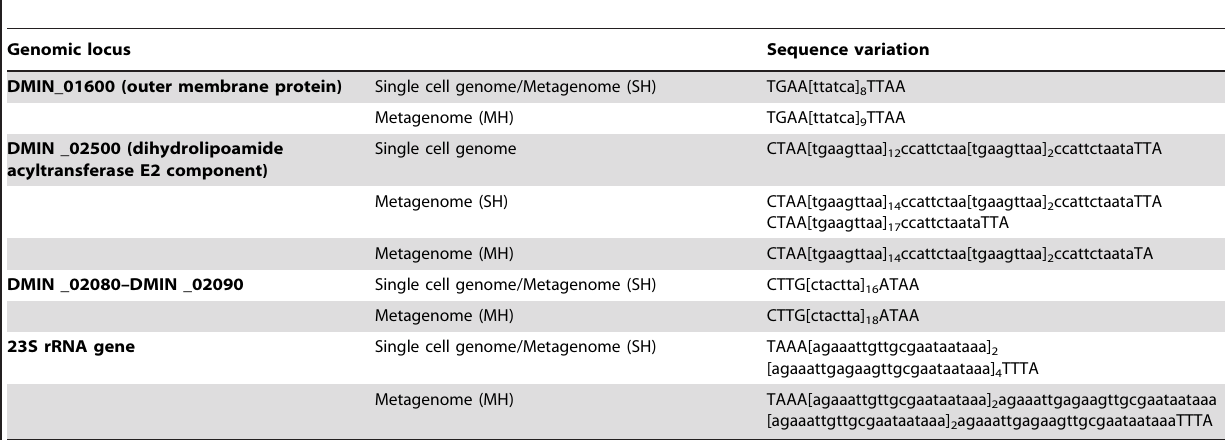
Table 3. Sequence variation detected between the single cell genome, the single bacteriome derived metagenome (SH, single host) and the pooled bacteriome derived metagenome (MH, multiple hosts).